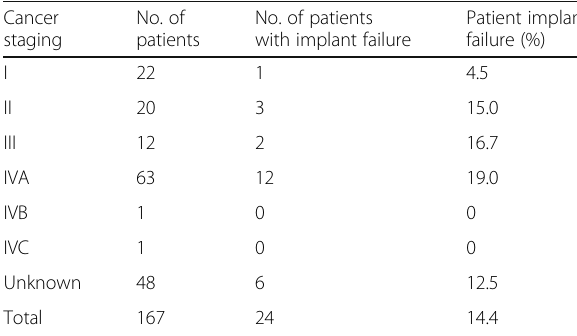
Table 2 Description of cancer staging and implant failures Cancer